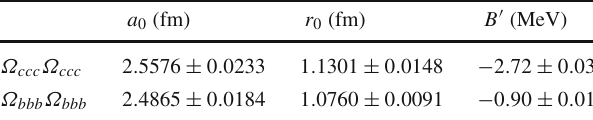
Table6 Thescatteringlength a 0 ,effectiverange r 0 ,andbindingenergy B (cid:9) of the Ω ccc Ω ccc and Ω bbb Ω bbb systems with J P = 0